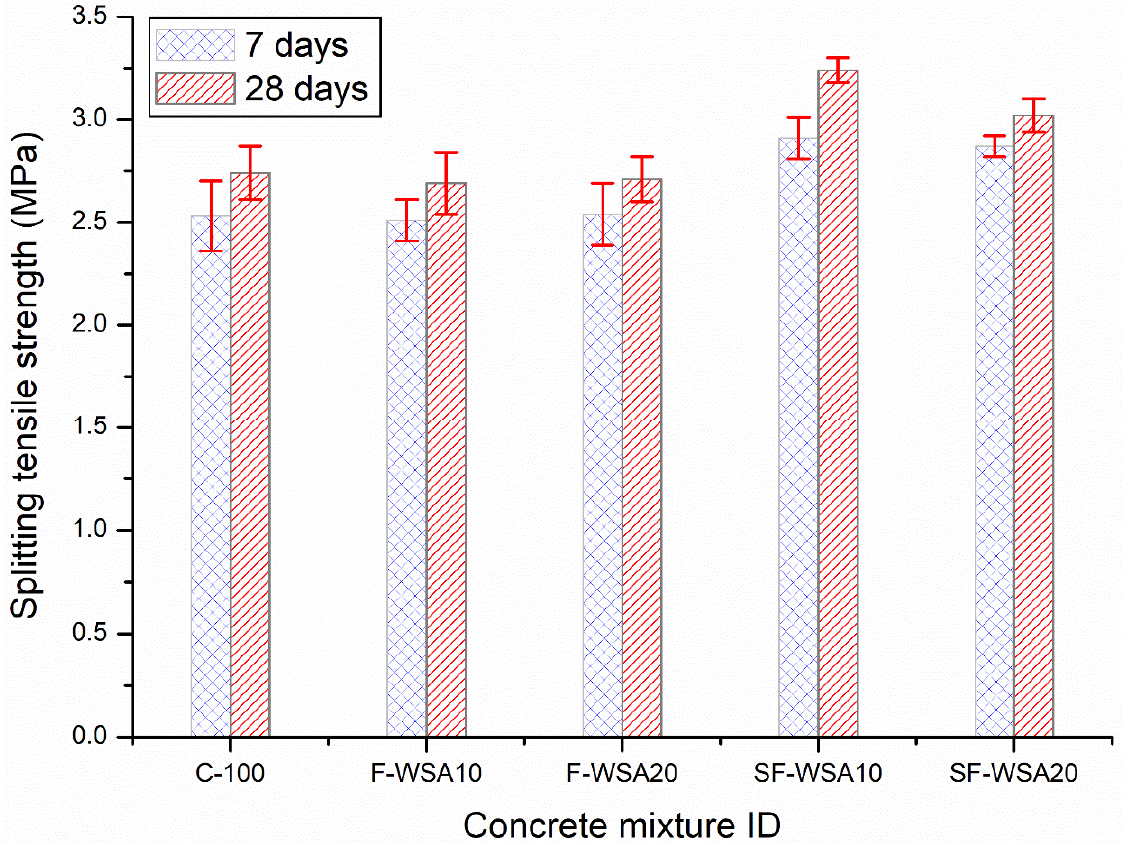
Figure 7. Comparison of 7-day and 28-day splitting tensile strength development between control and concrete containing F-WSA and SF-WSA.